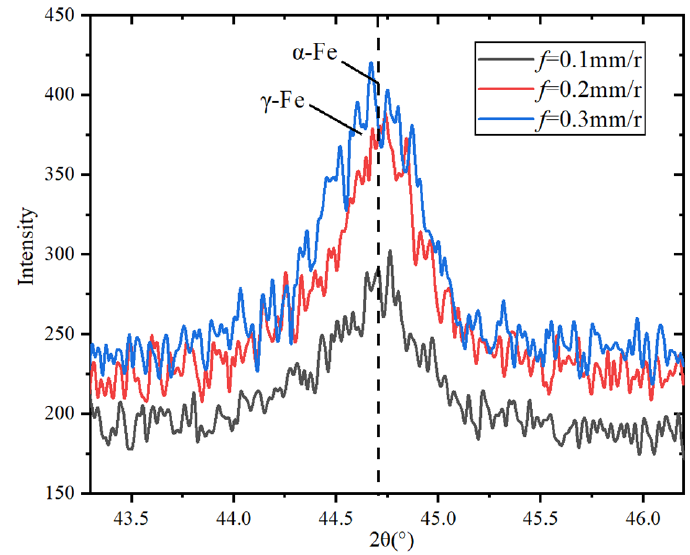
Figure 14. Effect of feed rate on diffraction peak of metamorphic layer.